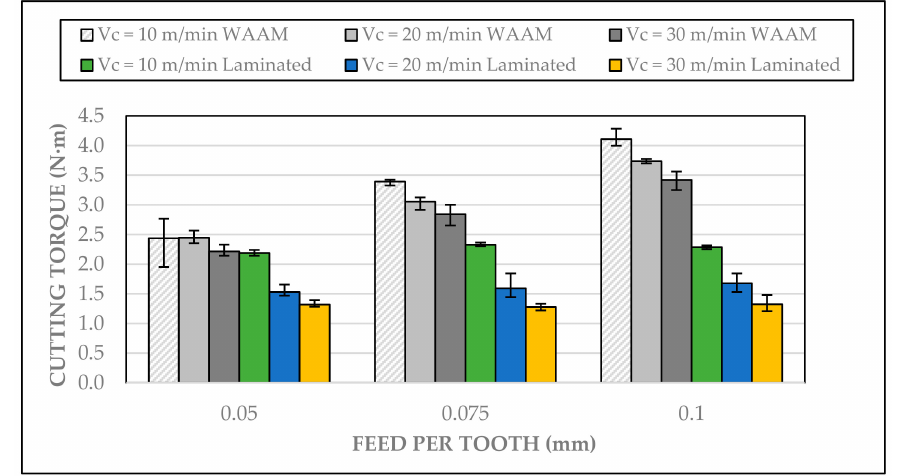
Figure 11. E ff ect of the cutting parameters and material manufacturing process on the cutting torque.